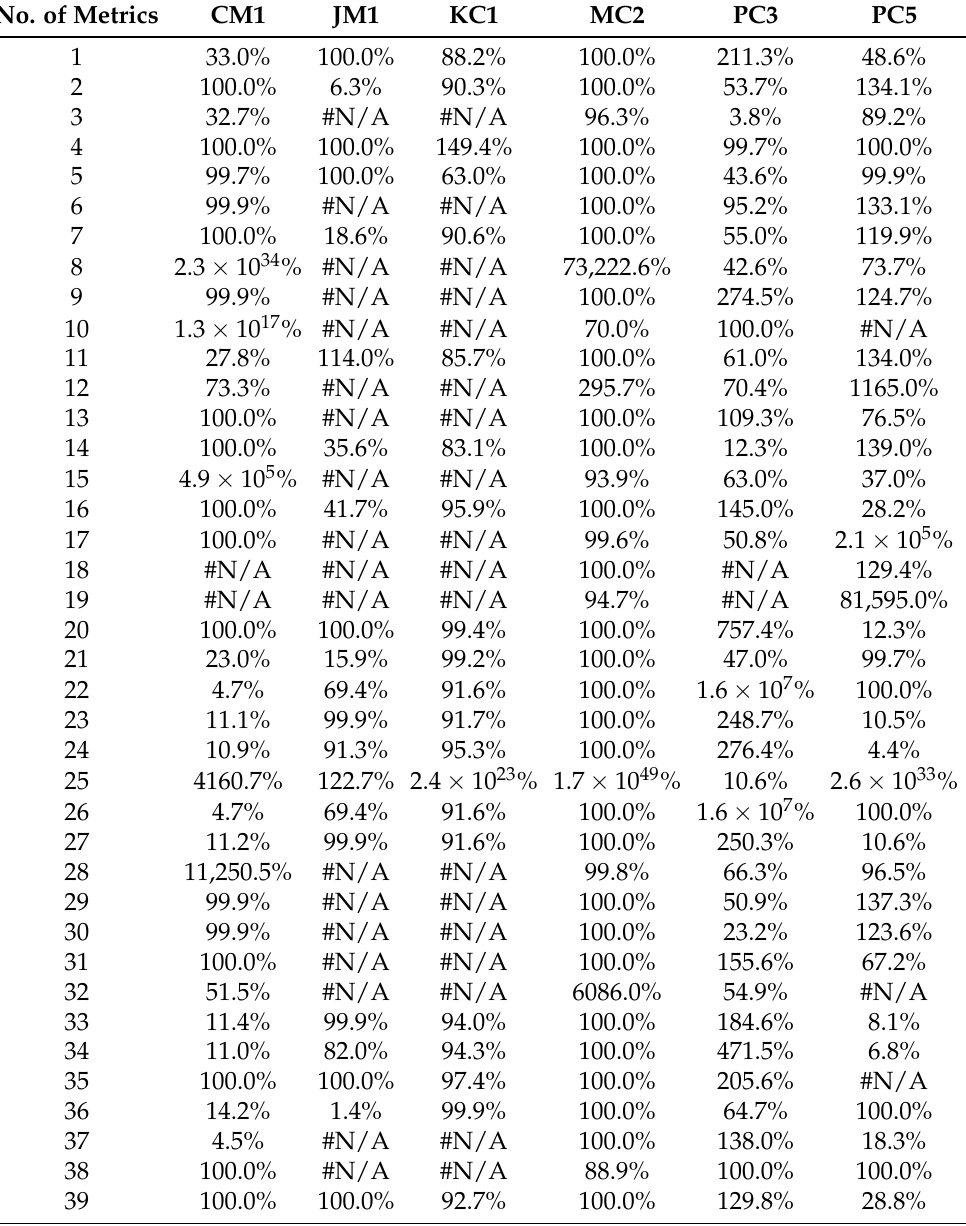
Table 4. Rate of change in odds ratio for each metric in different